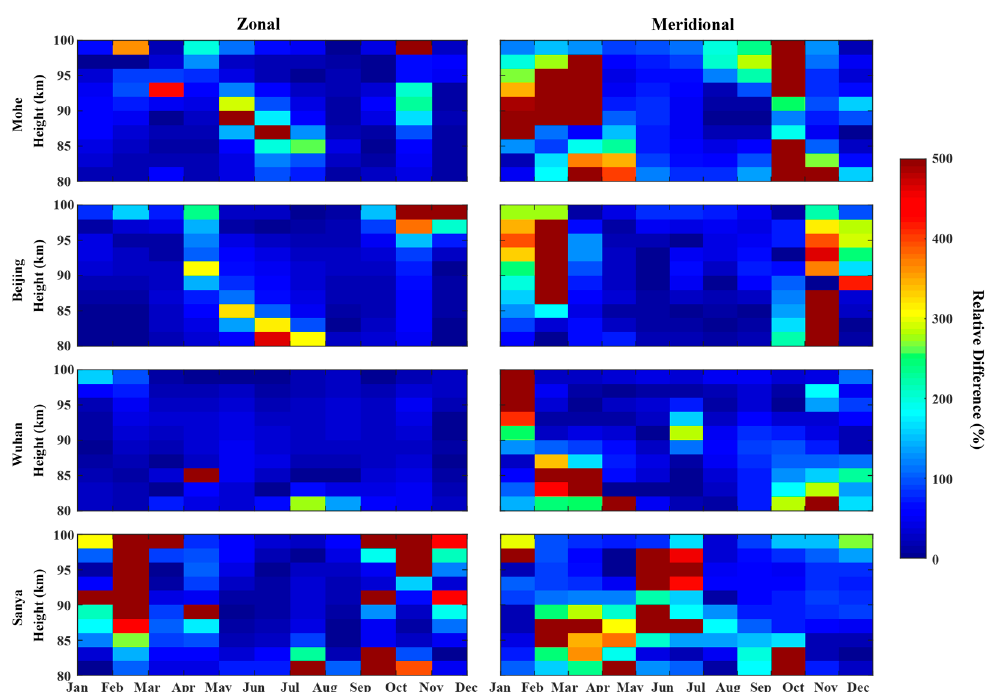
Figure 3. The relative difference between radar observation and HWM prediction.